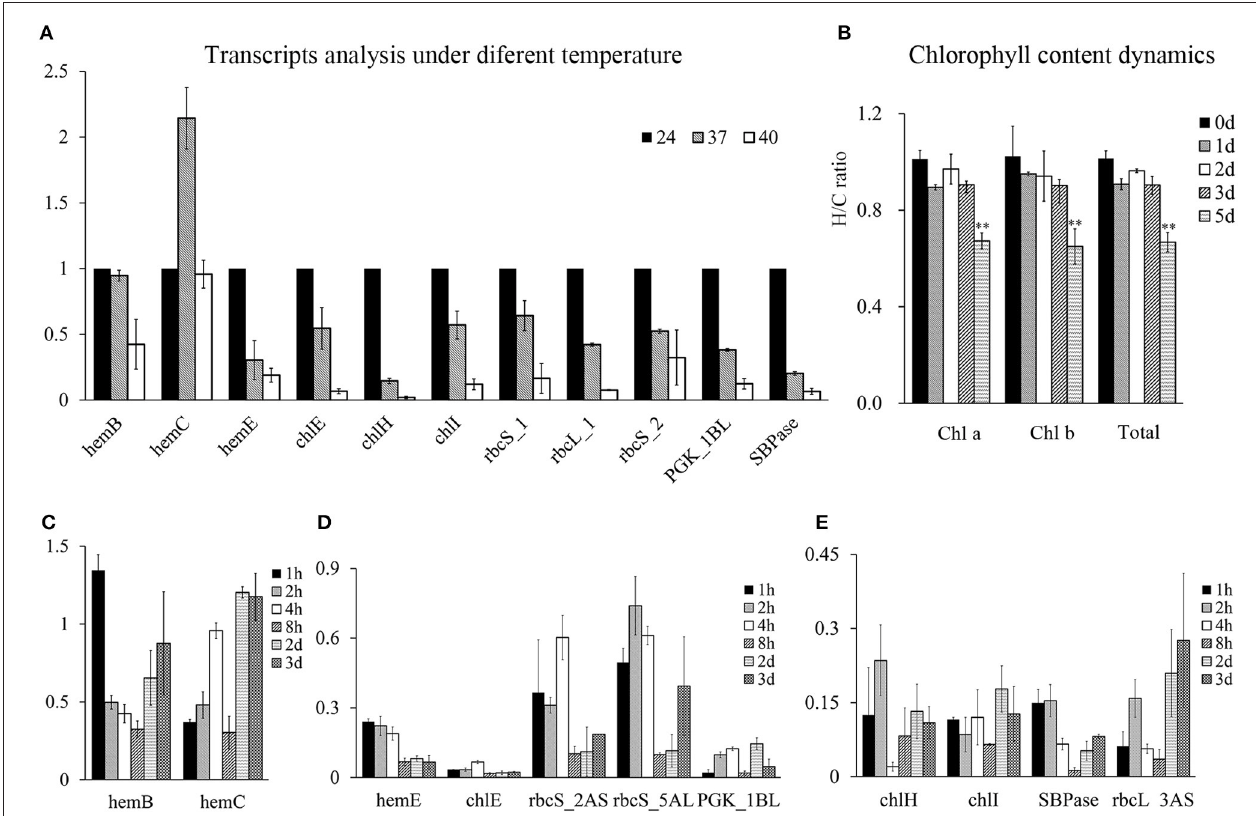
FIGURE 6 | Chlorophyll content dynamics and the photosynthesis process related genes expressions under heat stress at wheat seedling stage. The Y-axis represent fold changes (heat to control) in all figures. (A) Transcripts analysis of genes involved in chlorophyll synthesis and Calvin cycle under 24, 37, 40 ◦ C for 4 h under light condition. (B) Chlorophyll content dynamics under daylight heat stress at 40 ◦ C. (C–E) , time course analysis of mRNAs of chlorophyll synthesis and Calvin cycle related genes. Samples at time point of 2 and 3 d were obtained 4 h after light with heat